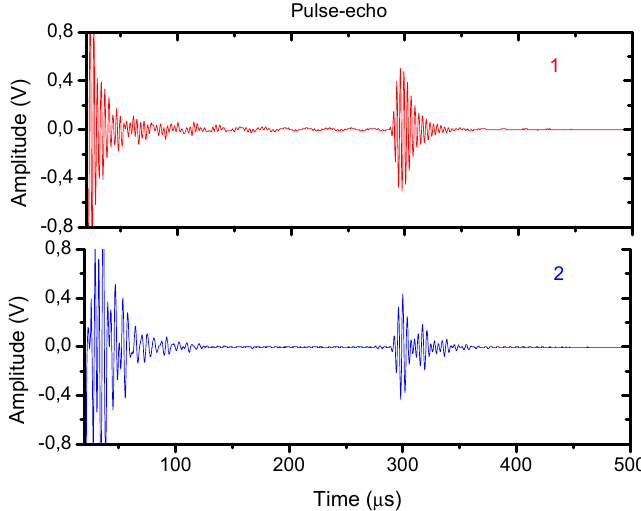
Figure 16. Pulse-echo mode of operation, wideband excitation (spike). 1. (Red) Air-coupled transducer with active matching layer. 2. (Blue) Conventional air-coupled transducer with passive matching layers.